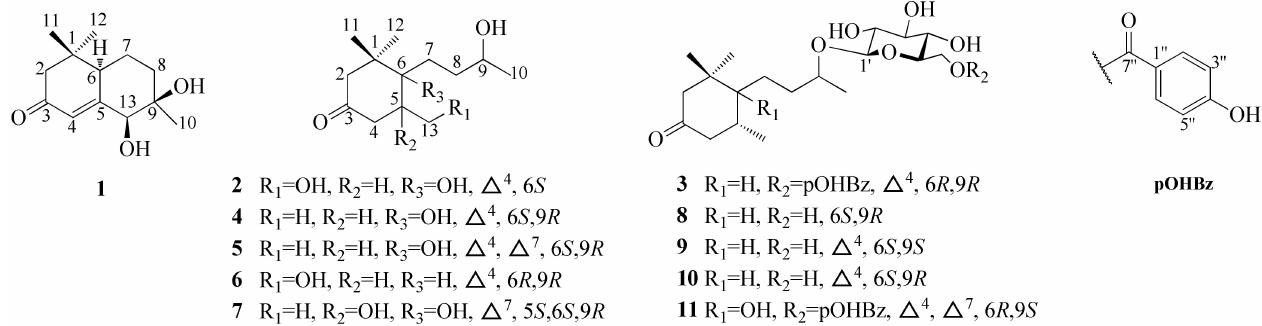
Figure 1. The structures of megastigmanes ( 1 – 11 ) isolated from Diaphragma juglandis Fructus.